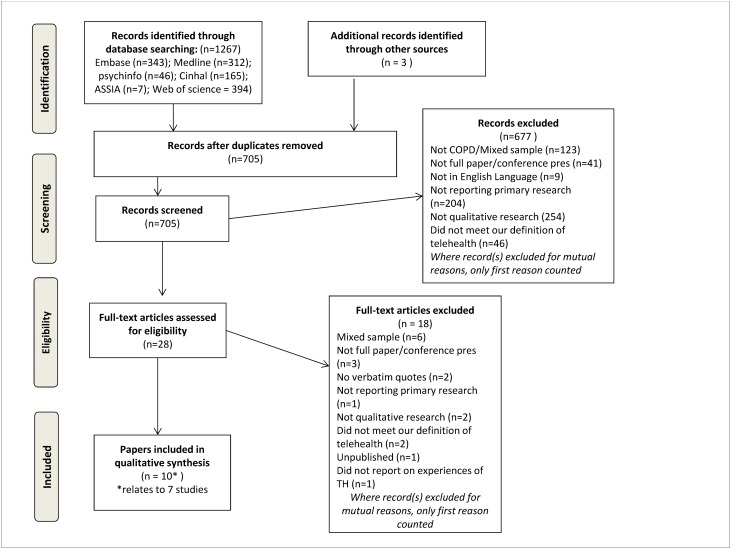
PRISMA flow diagram